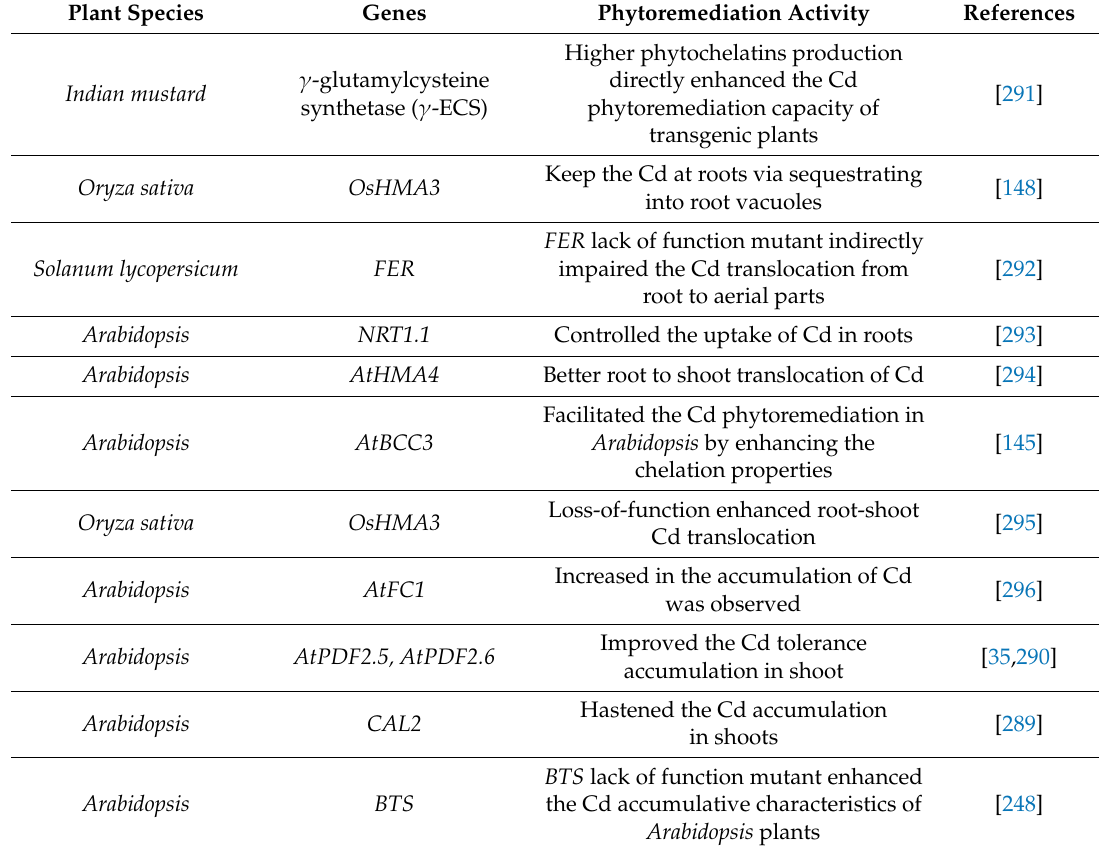
Table 7. Role of genetically modified plants in the detoxification and phytoremediation of Cd in soil. Plant Species